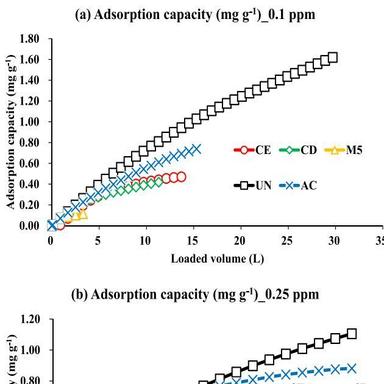
Adsorption capacities of the tested adsorbents toward low FA concentrations (0.1–0.5 ppm) (ambient temperature and 2 mg adsorbents).